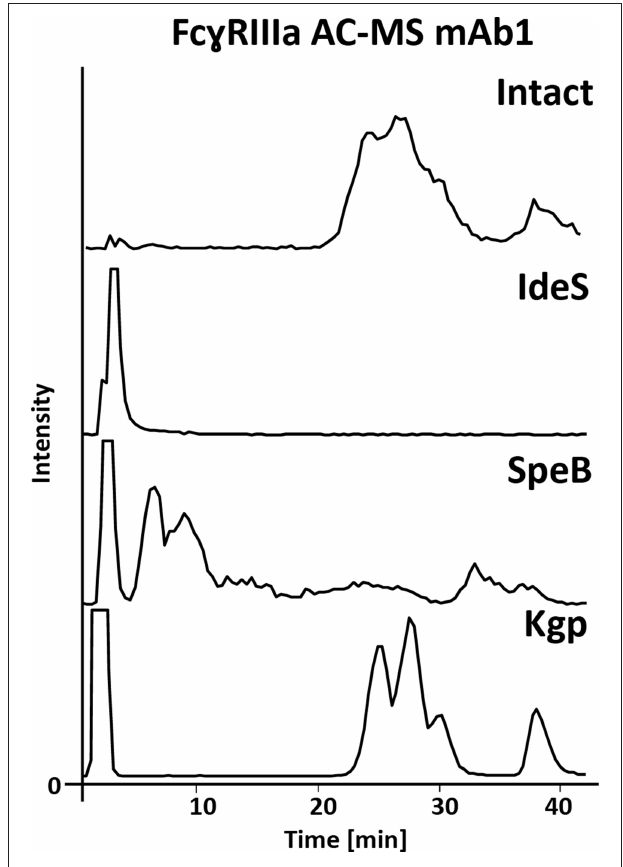
FIGURE 2 | Fc È RIIIa AC-MS base peak chromatograms of intact and IdeS-, SpeB-, and Kgp-digested mAb1. For intact and Kgp-digested mAb1, two distinct groups of peaks were detected, namely fucosylated forms with lower affinity (RT 20–35min) and afucosylated glycoforms with higher affinity (RT higher than 35min); see Figure 3